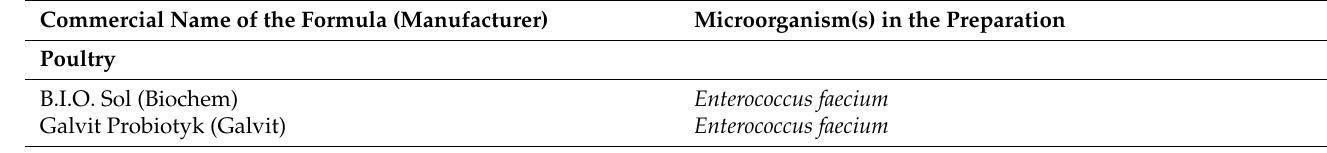
Table 2. Examples of enterococcal probiotic formulas used in nutrition of livestock (adapted from